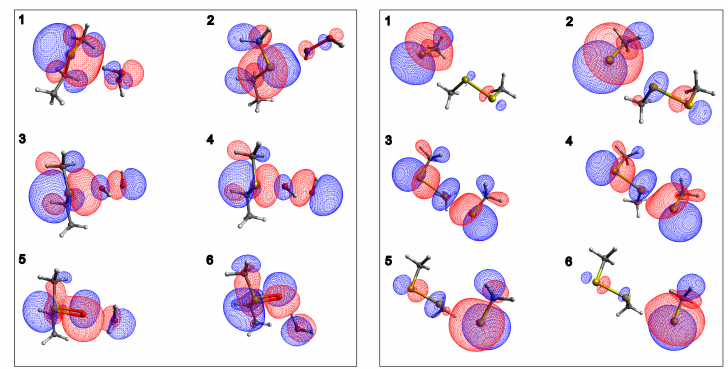
Figure 2. QC Highest Occupied Molecular Orbitals for six selected points of ( left ) Met Oxidation and ( right ) BU thiol/disulfide interchange reactions. In both cases, the MOs shape and direction underline the bond breaking/formation between interacting species. In the graphical representation, C atoms are in gray, O in red, S in yellow and H in white while blue (red) color highlights positive (negative) electron density. ESP atomic charges are reported in Table S1 of the Supplementary